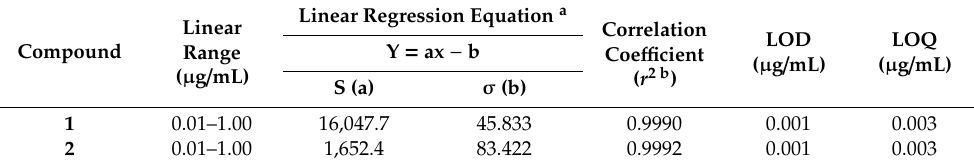
Table 2. Calibration curves, LOD, and LOQ of compounds 1 and 2